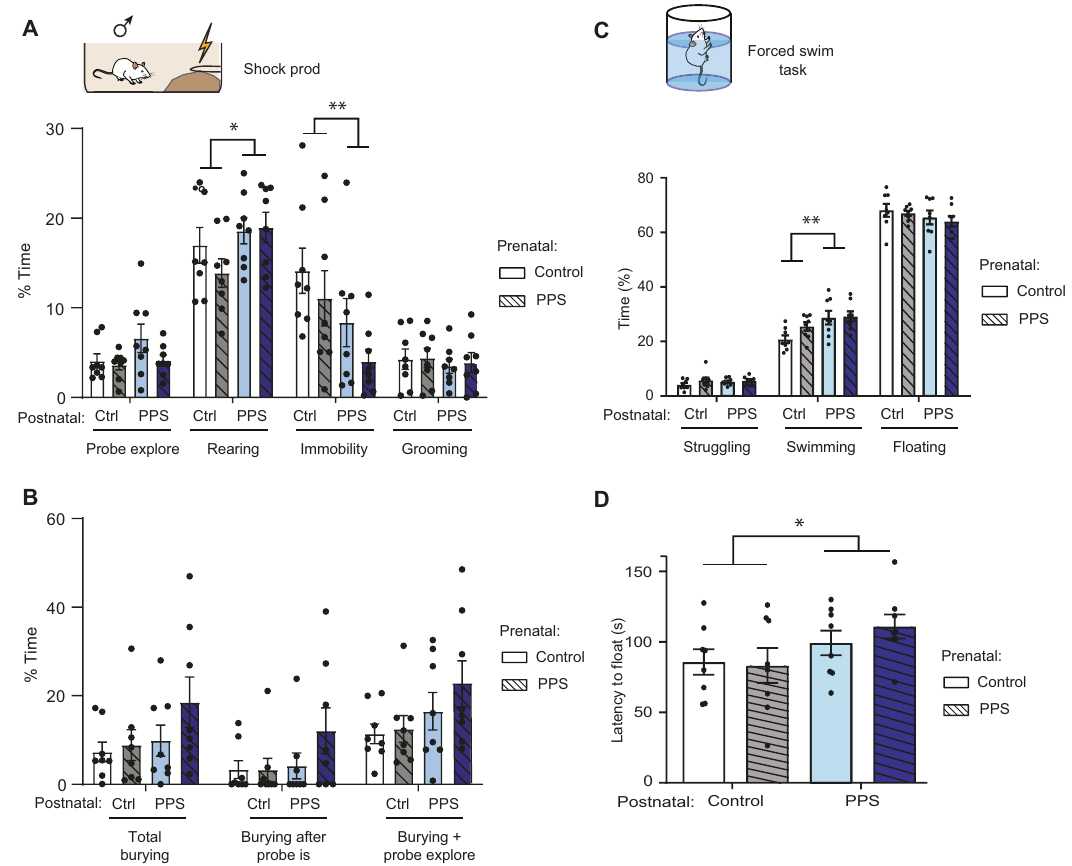
Fig. 4 Adults raised by PPS male-paired dams display enhanced coping behaviors. A Shock probe, passive coping — the pups born to or raised by PPS male-paired dams exhibited less immobility in response to the shock and increased rearing. B Shock probe, active coping — no signi fi cant difference was observed in pups reared by PPS male-paired dams in terms of probe burying or probe exploration. C Forced swim test. The pups raised by PPS male-paired dams showed more active coping by a postnatal increase in the time spent swimming. D The increase in swimming duration was accompanied by a postnatal effect on the latency to fl oat. n = 8 per group. The results are the mean ± s.e. m. Ctrl: Control, PPS: Peripubertally stressed rats. * P < 0.05, ** P < 0.01 , *** P <